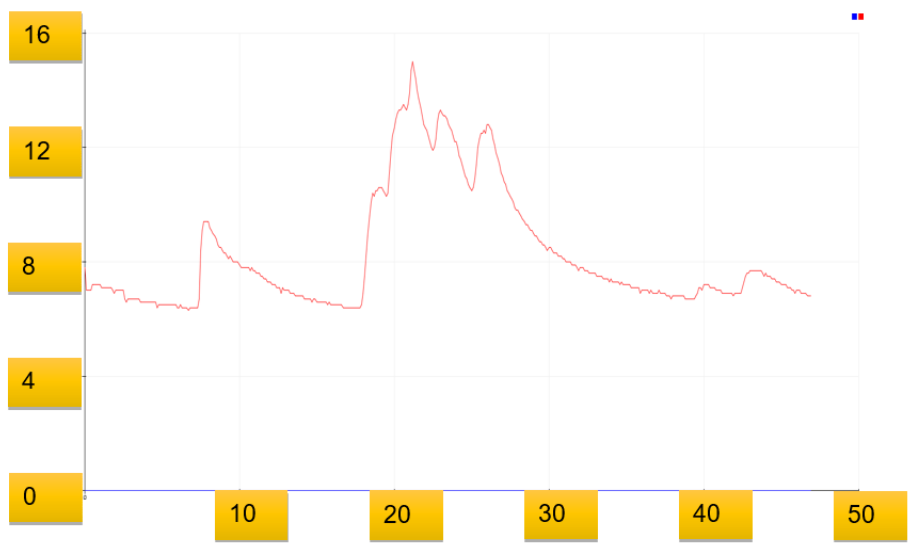
Figure 16. Smoke sensor in the presence of flame.